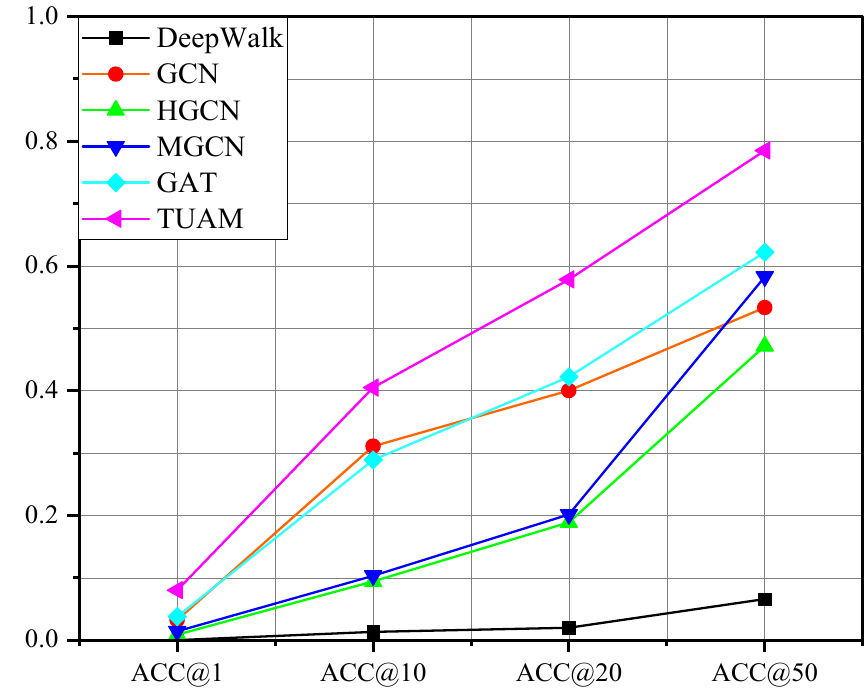
Figure 2. The accuracy of several models on the Facebook–Twi tt er dataset.